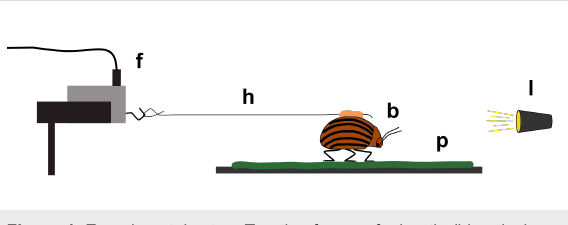
Figure 4: Experimental setup. Traction forces of a beetle (b) actively walking on a plant surface (p) were recorded by using a highly sens- itive force transducer (f). The beetle was fixed to the force transducer by a piece of hair (h) and attracted by a small light source (l). Adapted from